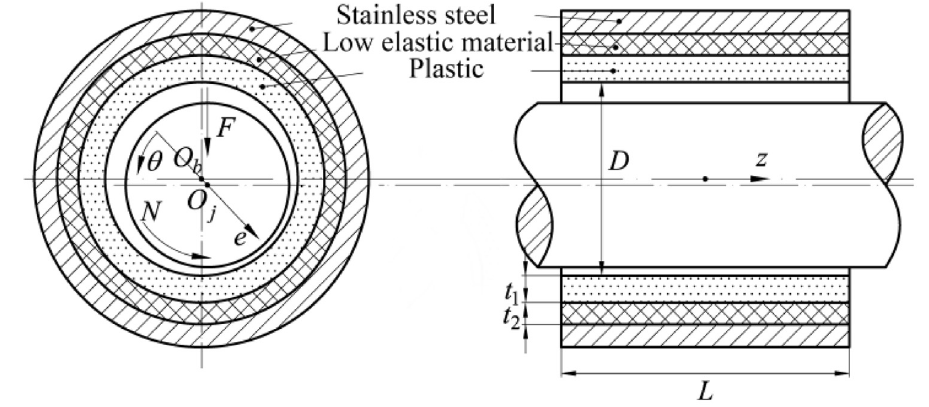
Fig. 1. Water-lubricated